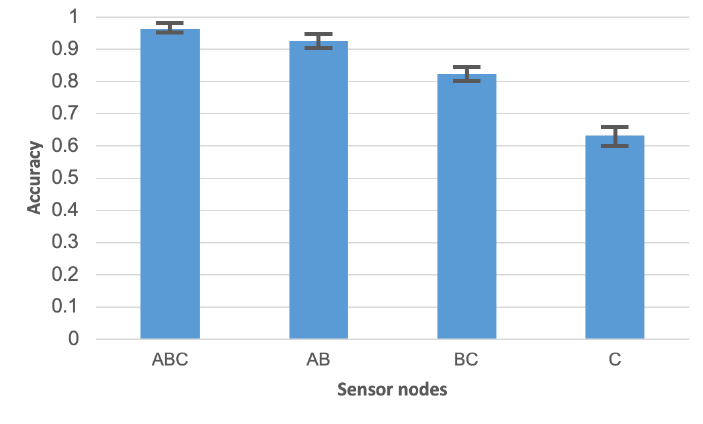
Figure 9. Comparison of activity recognition accuracy for sensor network and separate sensor nodes.